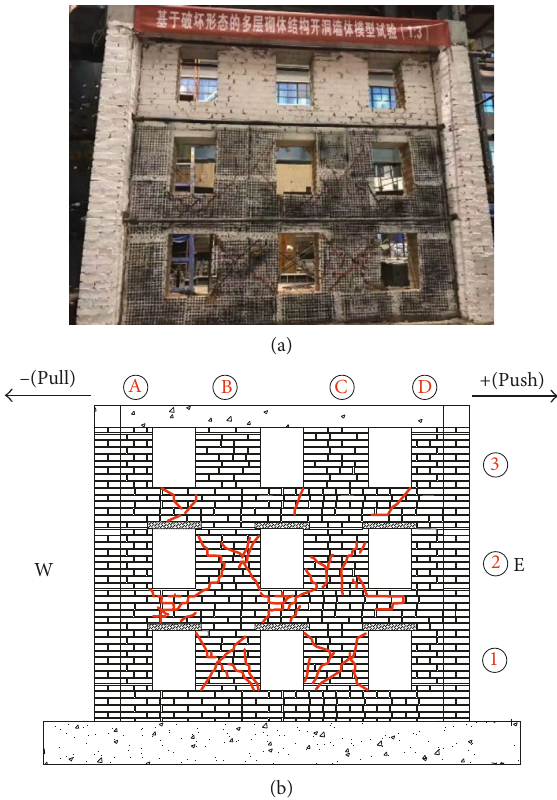
Figure 6: Final failure and crack pattern of the URM wall. (a) Final failure of the URM wall from the south side. (b) Crack schematic diagram of URM